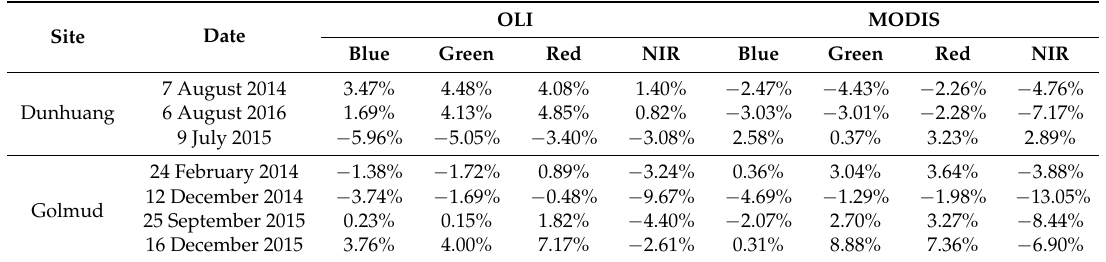
Table 11. The relative errors between cross-calibration coefficients and CRESDA site calibration coefficients. Site